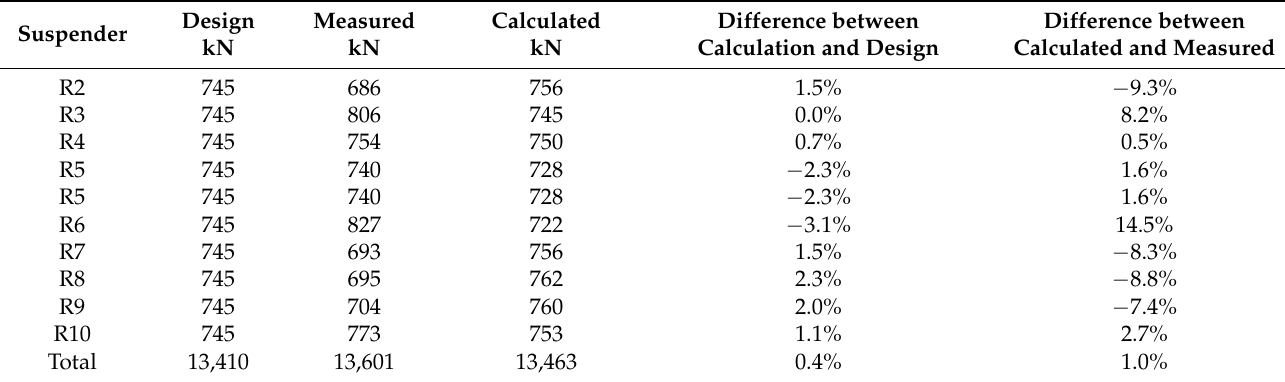
Table 2. Comparison of suspender-cable